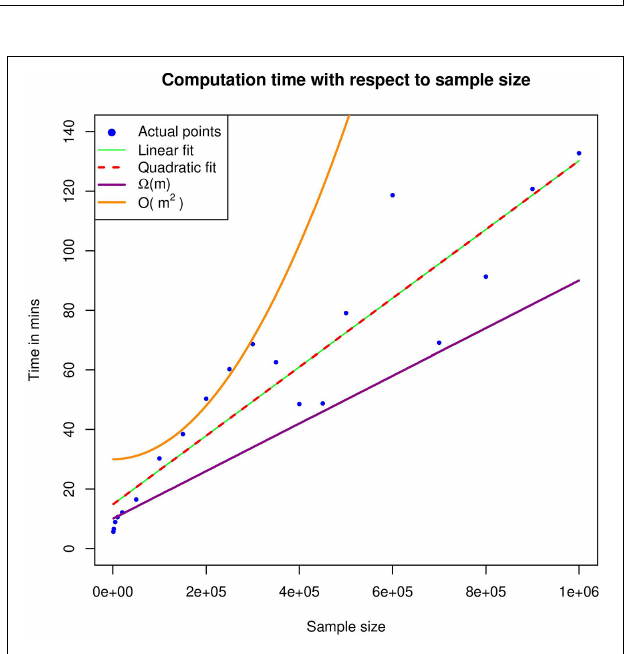
FIGURE 3 | Example of the output csv table with all relevant information of the fastq files.